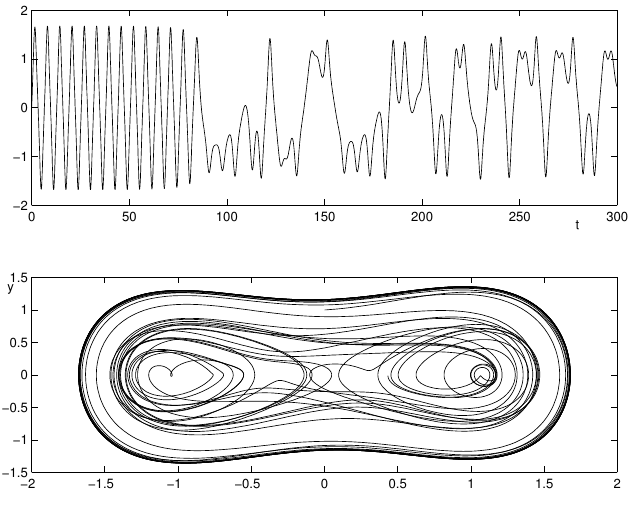
x Figure 6. Chaotic motion of the Duffing system for a = 0 . 25.